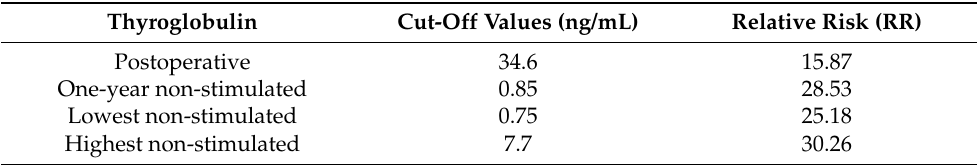
Table 6. Relative risk of structural disease based on cut-off values of thyroglobulin determined by ROC